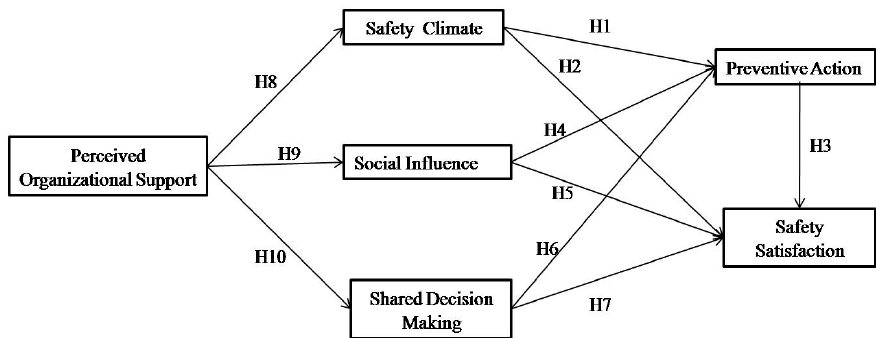
Figure 1. The proposed research model.